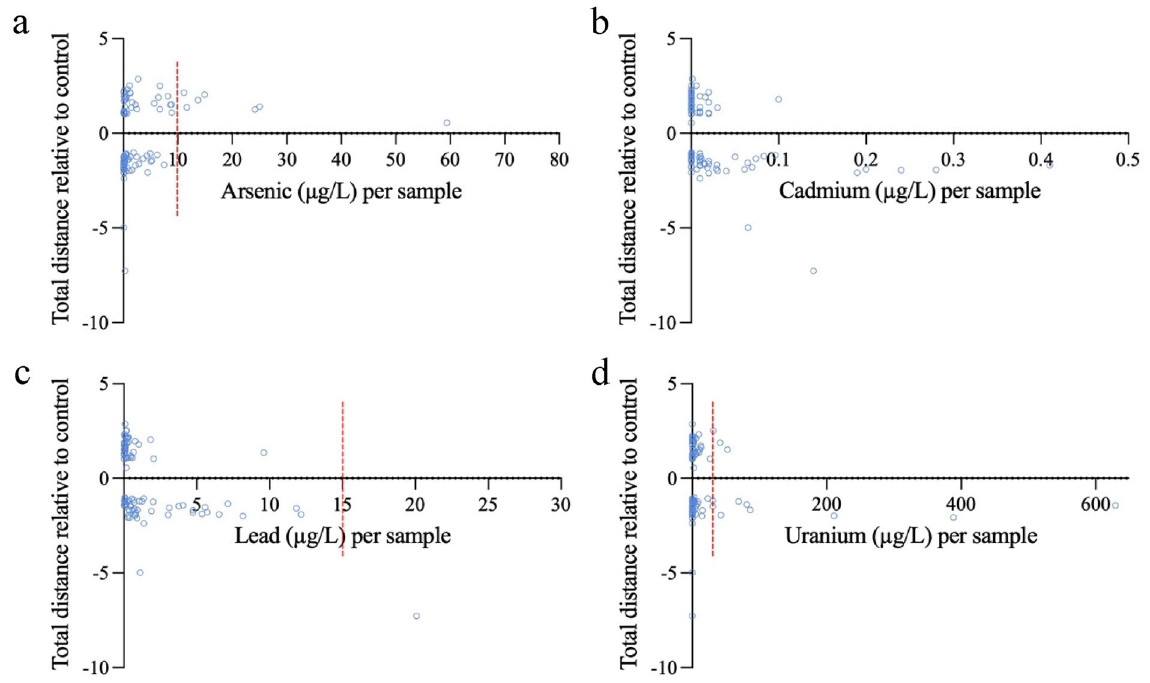
Figure 3. Dot plot representing total distance after a 1:1 sample/egg water exposure. Data is shown in the form of fold change difference between treatment relative to 100% egg water control against the amount of ( a ) arsenic (µg/L), ( b ) cadmium (µg/L), ( c ) lead (µg/L), and ( d ) uranium (µg/L) present in a given sample. Dashed red line represents current EPA maximum contaminant levels in drinking water. Samples that induced significant hyper or hypoactivity can be found in Supplemental Table SI, p value < 0.05, ANOVA, n =